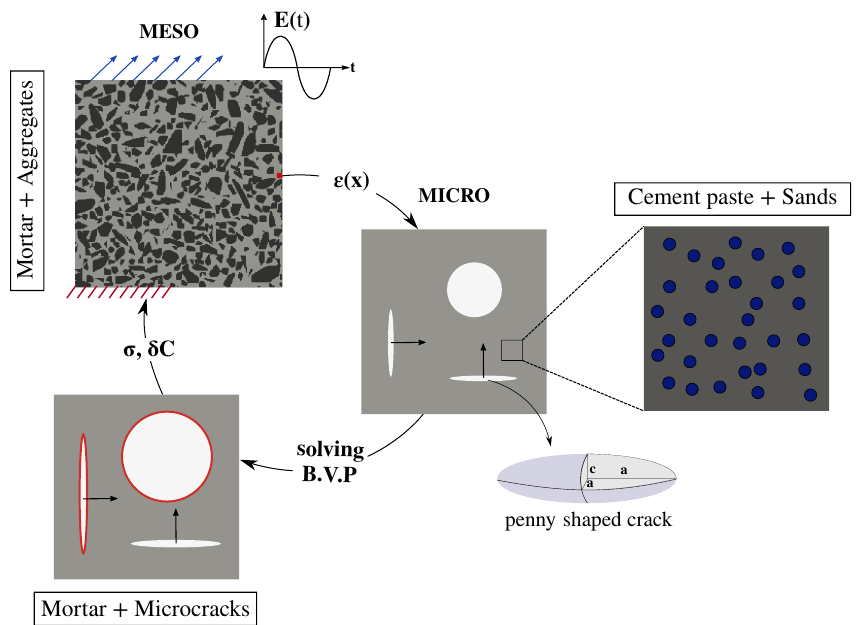
Figure 4. Schematic illustration of the multiscale computational homogenisation approach considered in this